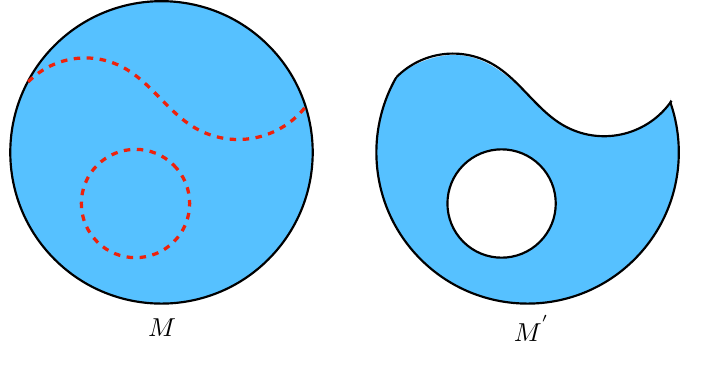
Figure 3 . Shrinking M to M